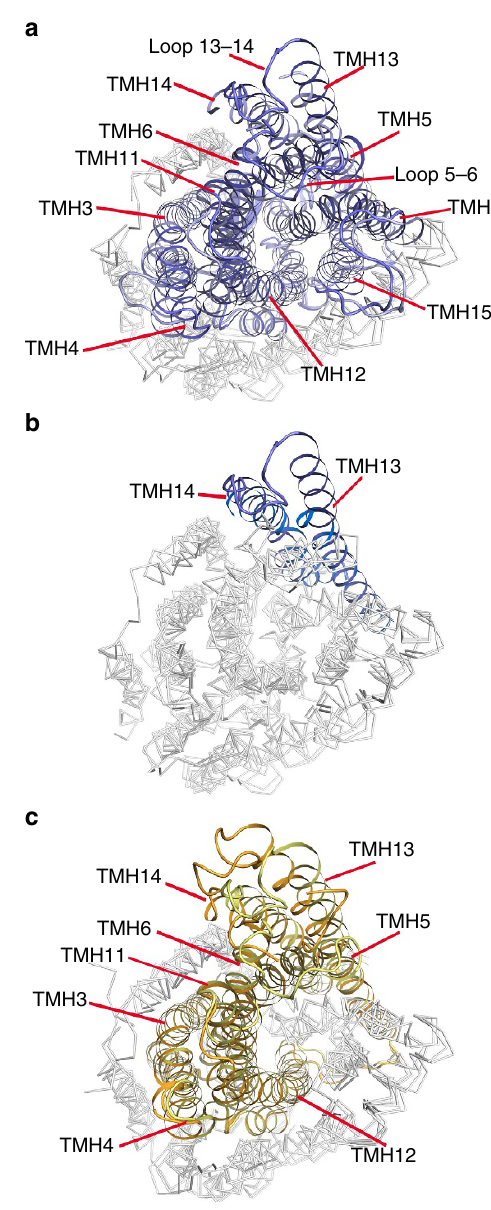
Figure 3 | Movements associated with constriction and opening of the active site. ( a ) Comparison of TmPPase:IDP (blue) and TmPPase:Ca:Mg (light blue). TMHs 3, 4, 5, 6, 11, 12, 13, 14, 15 and 16, which move between these two states are labelled and coloured, while the rest is in grey. Loops 5–6 and 13–14, which are visible in TmPPase:IDP but not in TmPPase:Ca:Mg, are also labelled. ( b ) Comparison of TmPPase:IDP and TmPPase:P i2 (sky blue). Moving TMHs 13 and 14 are labelled and coloured. ( c ) Comparison